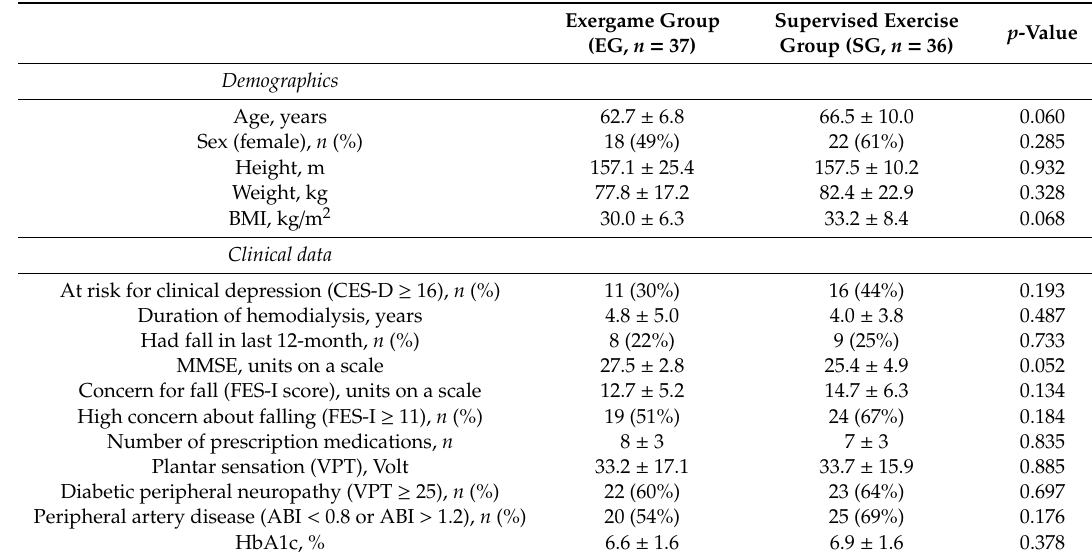
Table 1. Demographics and clinical data of the study